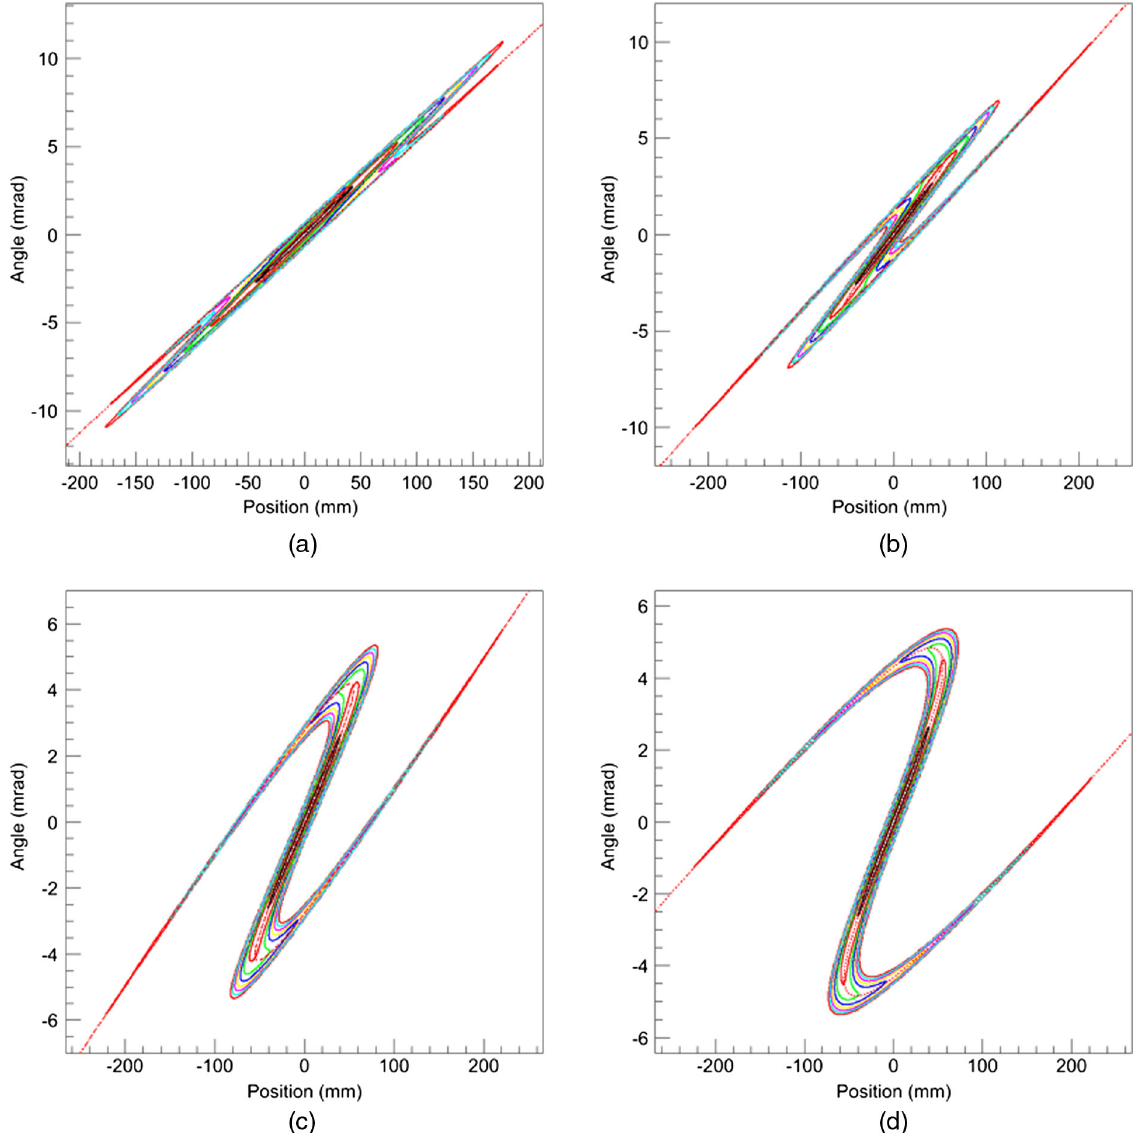
FIG. 22. Transverse phase space distribution at target obtained by tracking with octupole strength ( K 8 ) obtained using Eq. (A13) for various phase advance cases of cot ϕ 1, 3, 5, and 7 shown in panels (a) – (d),